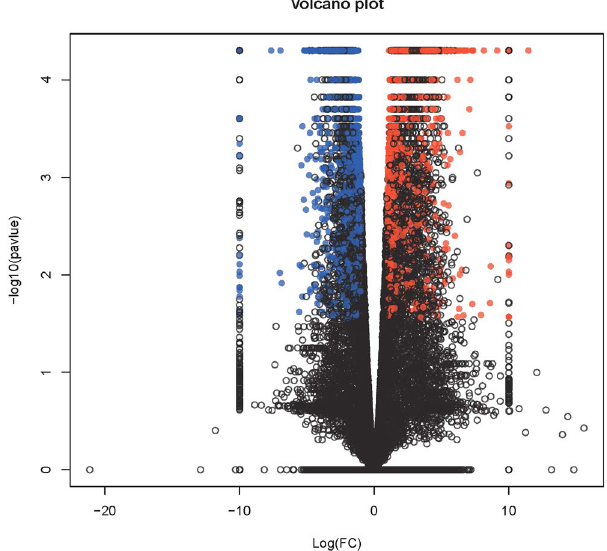
Figure 3. Volcano plot for the liver gene libraries of the CMC-FeS treated group and control group of zebrafish by showing variance in gene expression with respect to fold change (FC) and significance (P-value). Each dot represents an individual gene: Red dots represent the up-regulated DEGs (2593), Blue dots represent the down- regulated DEGs (3200), and black dots represent not differentially expressed genes